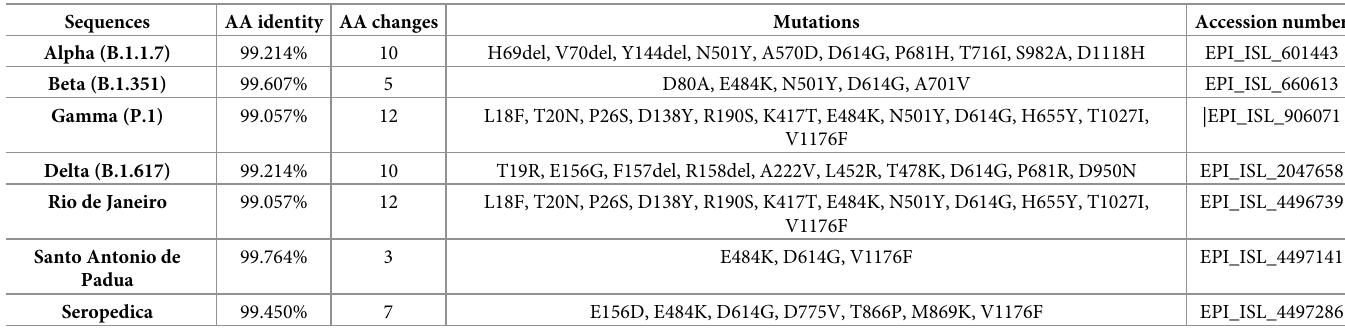
Table 4. Protein S mutations of each VOC and studied sequences.